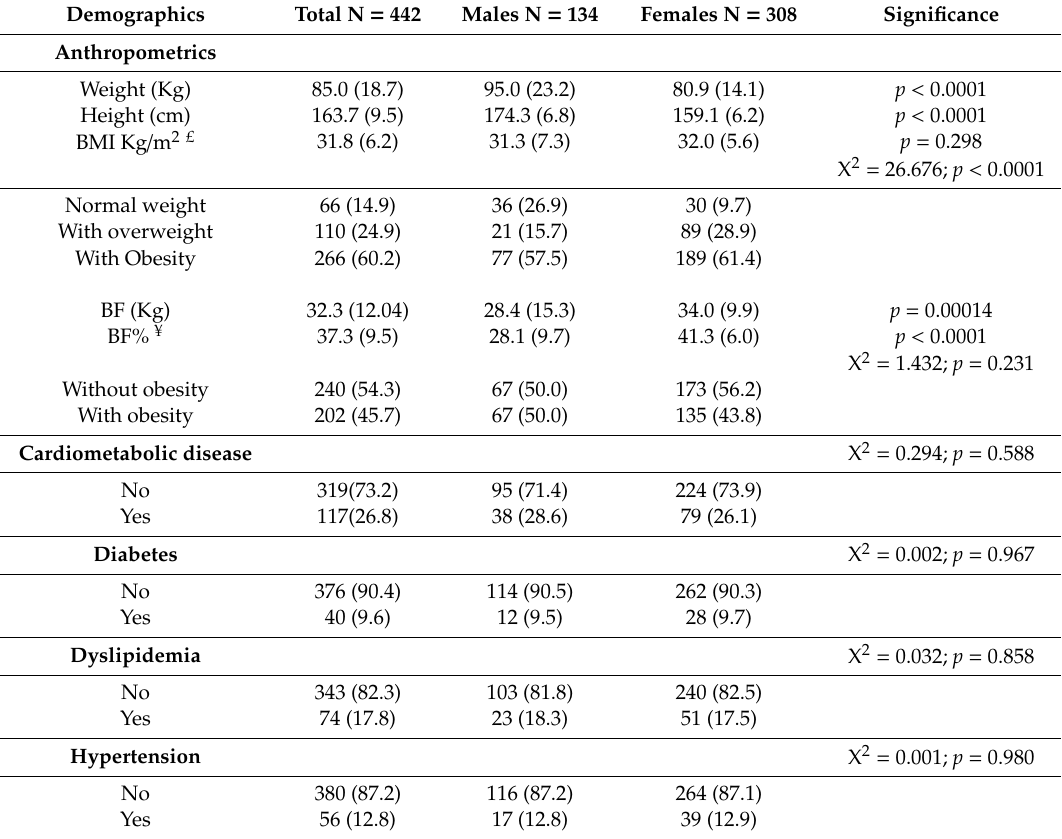
Figure 1. Association between BMI and BF% of the study sample (n = 442).